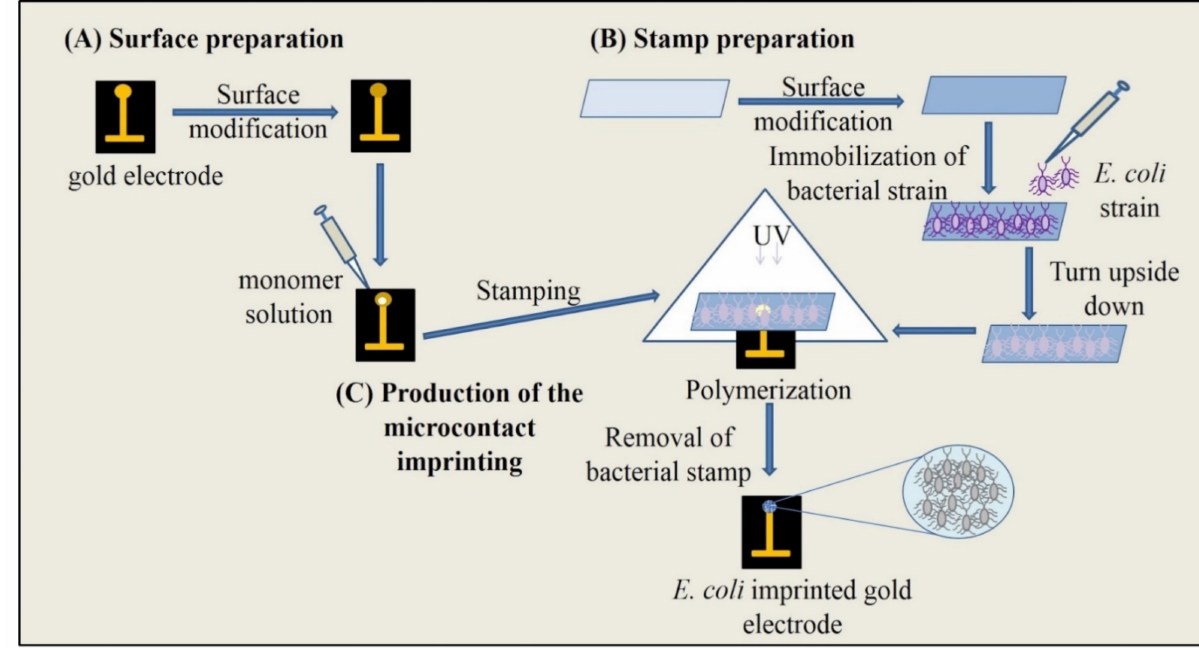
Figure 1. Schematic representation of microcontact imprinting of E. coli onto the polymer modified surfaces. ( A ) preparation of electrode surface, ( B ) preparation of bacteria stamps, ( C ) production of the microcontact imprinting (reproduced with permission from